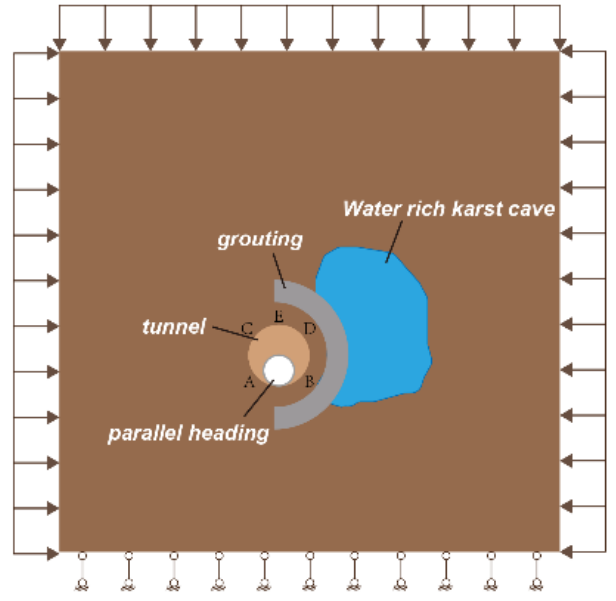
Figure 12. Diagram of the numerical calculation model.